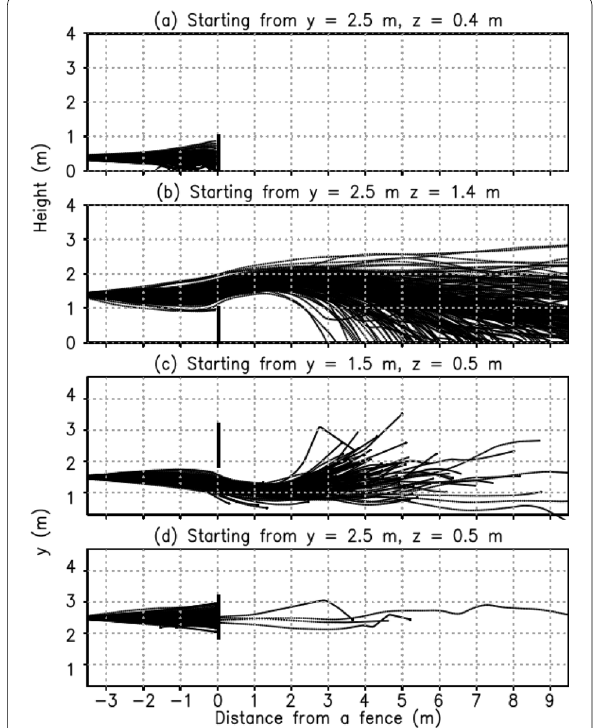
Fig. 12 Ensemble trajectories of snow particles at a , b the center of the y -axis and c , d along z 0.5 m around the three-dimensional = fence driven by all the wind data segments. The initial positions of the particles are ( y , z ) a (2.5 m, 0.4 m), b (2.5 m, 1.4 m), c (1.5 m, 0.5 m), = and d (2.5 m, 0.5 m). The position of the fence is shown by a solid line